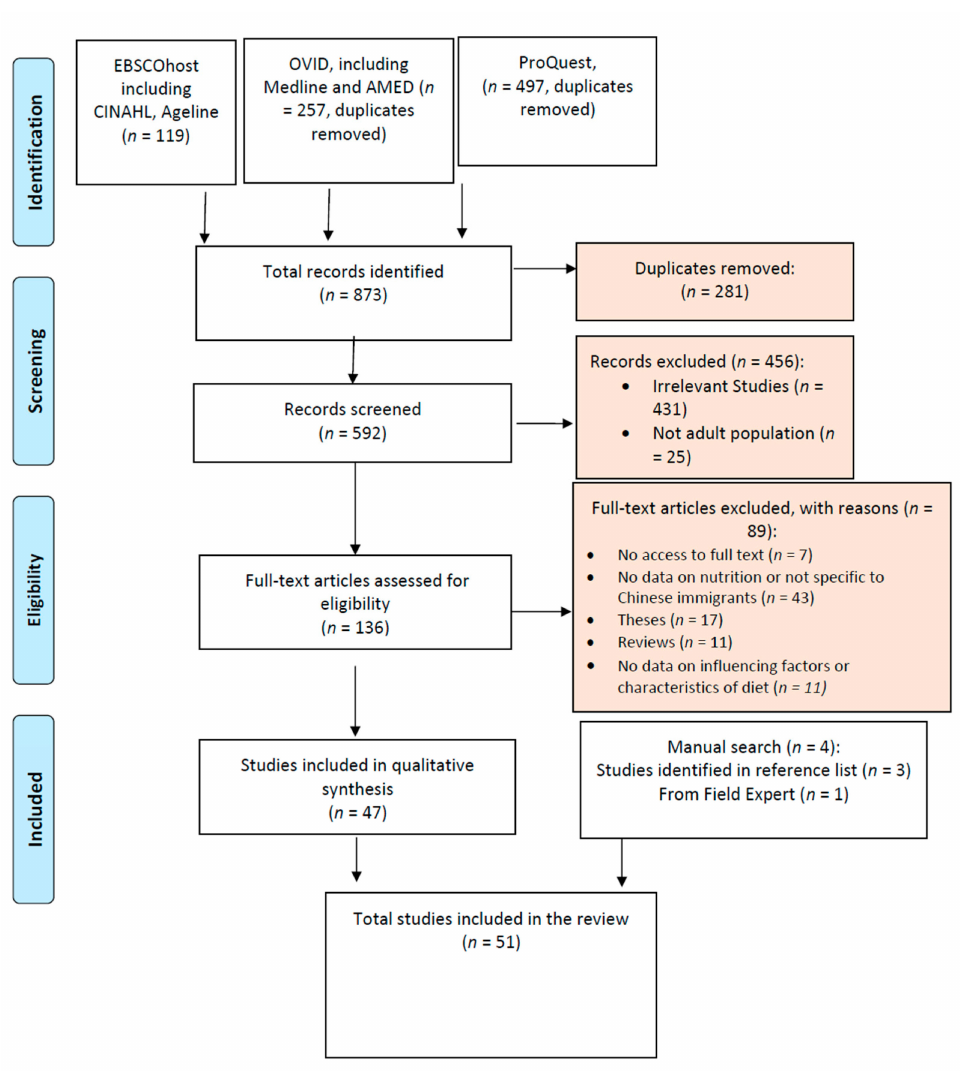
Figure 1. Study selection flow